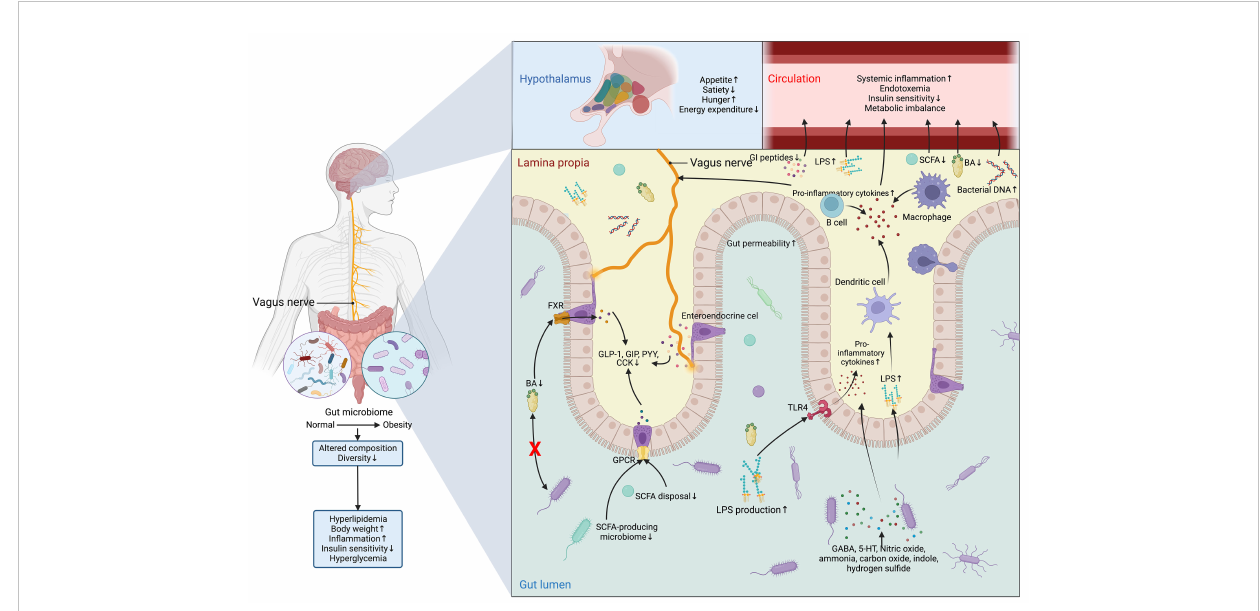
FIGURE 7 Dysfunction of the microbiome-gut-brain axis in obesity and T2DM. The composition and diversity of the gut microbiome are signi fi cantly altered in obesity. Apart from the consequent aberrances in the metabolism and metabolites of the microbiomes, such as the decrease in the production of BAs and SCFAs and the increase in LPS, the protective function of the gut is compromised by the increased permeability resulting from the in fl ammatory stimulations of nitric oxide, ammonia, carbon oxide, indole, and hydrogen sul fi de, allowing the drastic elevation in the fl ux of LPS, which can not only activate the TLR4 on enterocytes to promote the secretion of in fl ammatory cytokine and recruit in fl ammatory dendritic cells, B cells, and macrophages, but also directly inducing the production of in fl ammatory cytokines from these cells. Meanwhile, the profound reduction in the production of SCFAs and BAs leads to the subsequent drop in the activation of GPCR and FXR in enteroendocrine cells to sustain the production of GI hormones vital for energy homeostasis, which include GLP-1, GIP, PYY, and CCK. All these peptides have both peripheral and central effects on modifying the host metabolism and regulation of appetite directly through the vagus nerve or indirectly via immunoneuroendocrine mechanisms. Centrally, the aberrant hormonal signals transmitted from the gut to the hypothalamus in the brain result in aberrant eating behavior and metabolic control. While peripherally, the in fl ux of LPS, pro-in fl ammatory cytokines, and bacterial DNA, along with inadequate SCFAs, Bas, and GI peptides in the circulation further exacerbates insulin signaling and metabolic imbalance. Altogether, these central and peripheral abnormalities in metabolic control eventually lead to hyperglycemia. 5-HT, 5-hydroxytryptamine; BA, BA; CCK, cholecystokinin; FXR, Farnesoid X receptor; GABA, g - aminobutyric acid; GI, gastrointestinal; GIP, glucose-dependent insulinotropic polypeptide; GLP-1, glucagon-like peptide 1; GPCR,